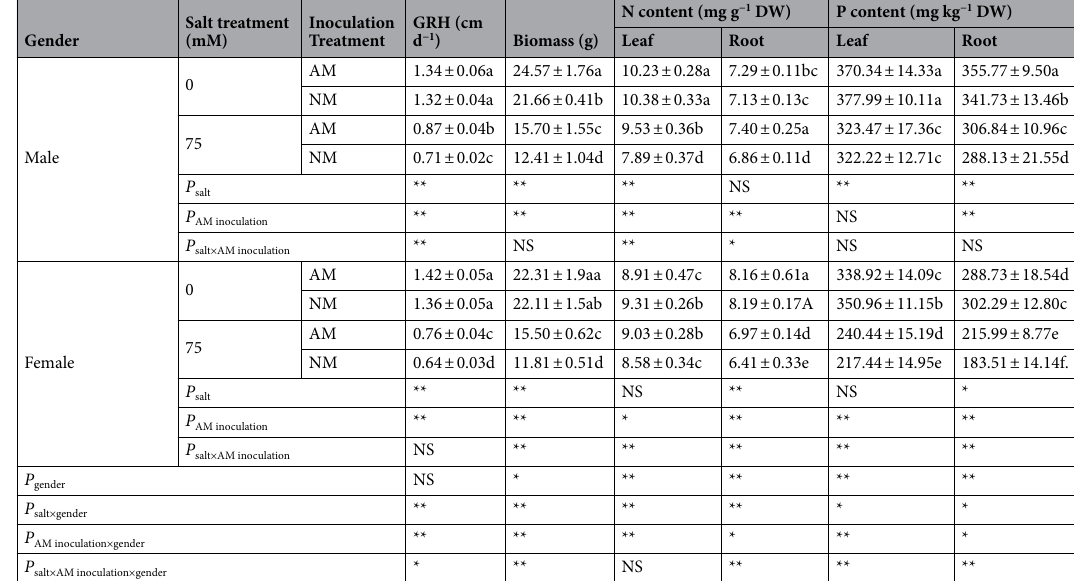
Table 1. Effects of AMF inoculation on growth parameters and nutrient acquisition of P. cathayana females and males under different salt conditions. AM, exogenous AMF inoculation; NM, non-exogenous AMF inoculation; 0 mM, without salt stress; 75 mM, under salt stress. **: significant effect at P ≤ 0.01; *: significant effect at 0.01 ≤ P ≤ 0.05; NS: no significant effect P > 0.05. Different lowercase letters indicate significant difference ( P ≤ 0.05), the data are means ± SD (n =